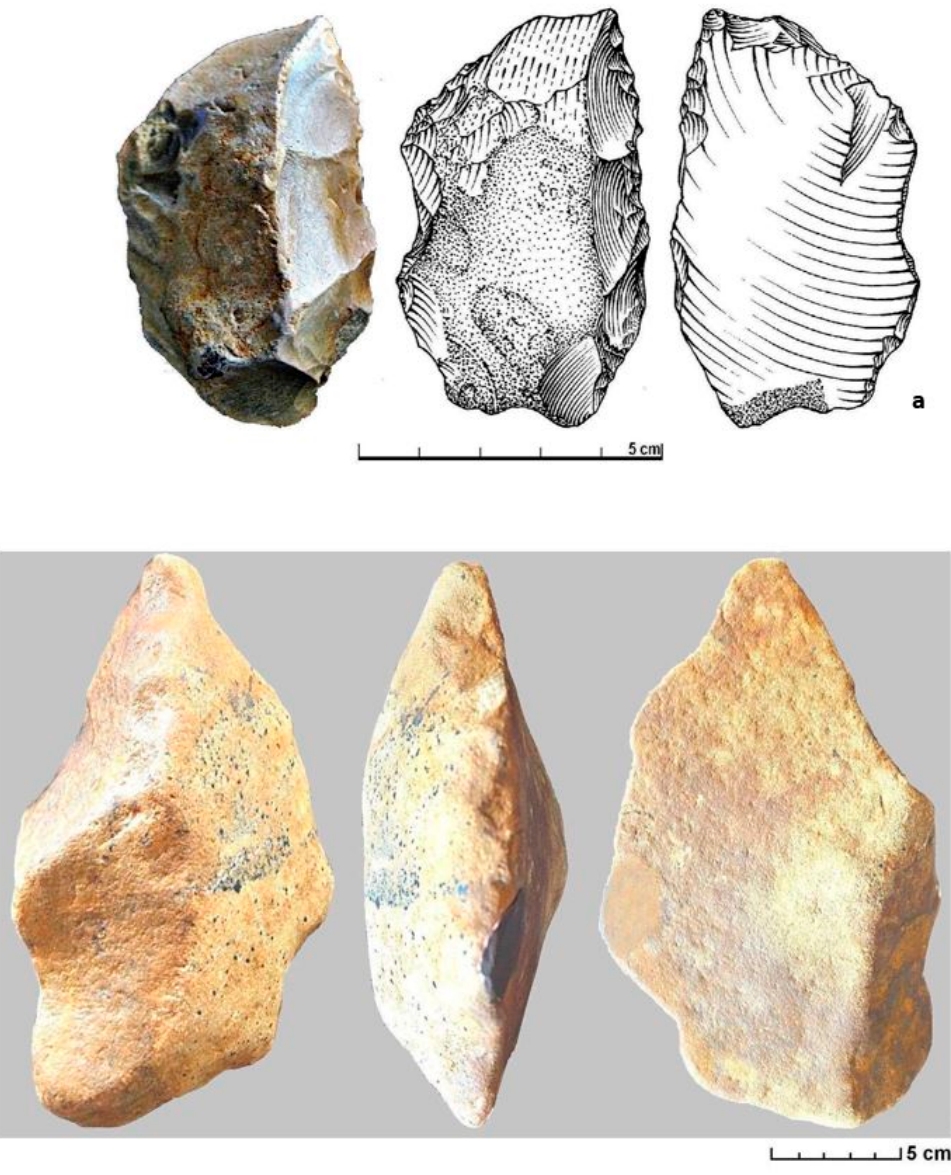
Figure 25. Dorsten-Schermbeck. ( a ) Denticulated knife (flint), in situ find; ( b ) side-struck flake with a pic-like tip, rolled, from the floor of the pit. (Drawing: B. Kaletsch, photo: H. Klingelhöfer.).